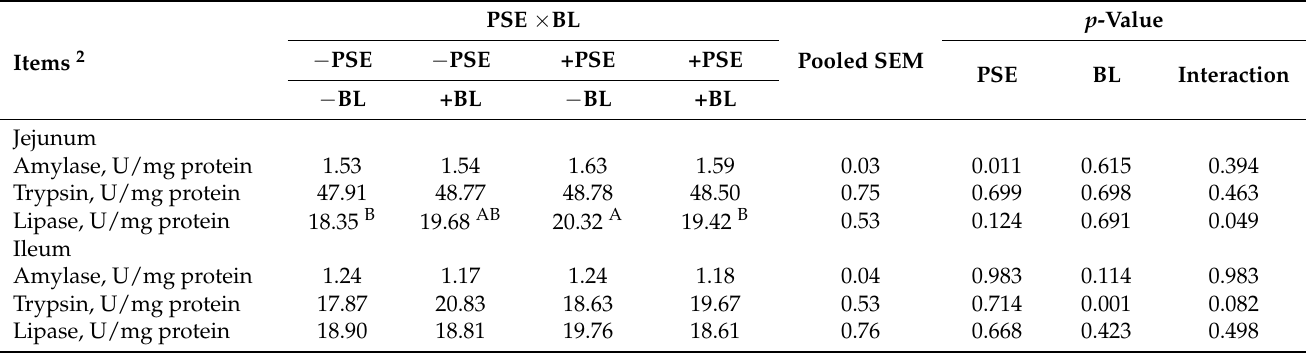
Table 5. Effects of BL and PSE on digestive enzymes in the jejunum and ileum 1 .